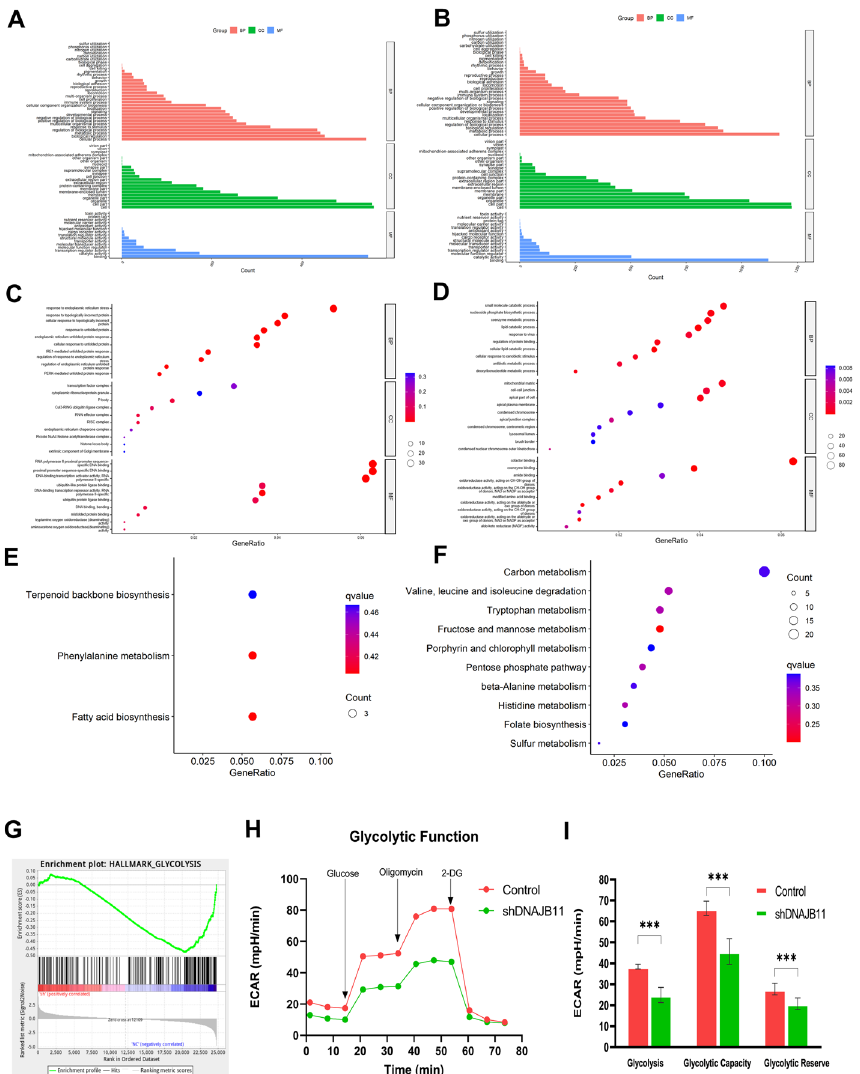
Fig. 4 Bioinformatic analysis of WT and DNAJB11-knockdown transcriptomic sequencing identifies DNAJB11 as a regulator of glycolytic function. A – D Gene Ontology (GO) functional classification and subcellular functional annotation of DEGs (837 upregulated genes in WT and 1499 downregulated genes